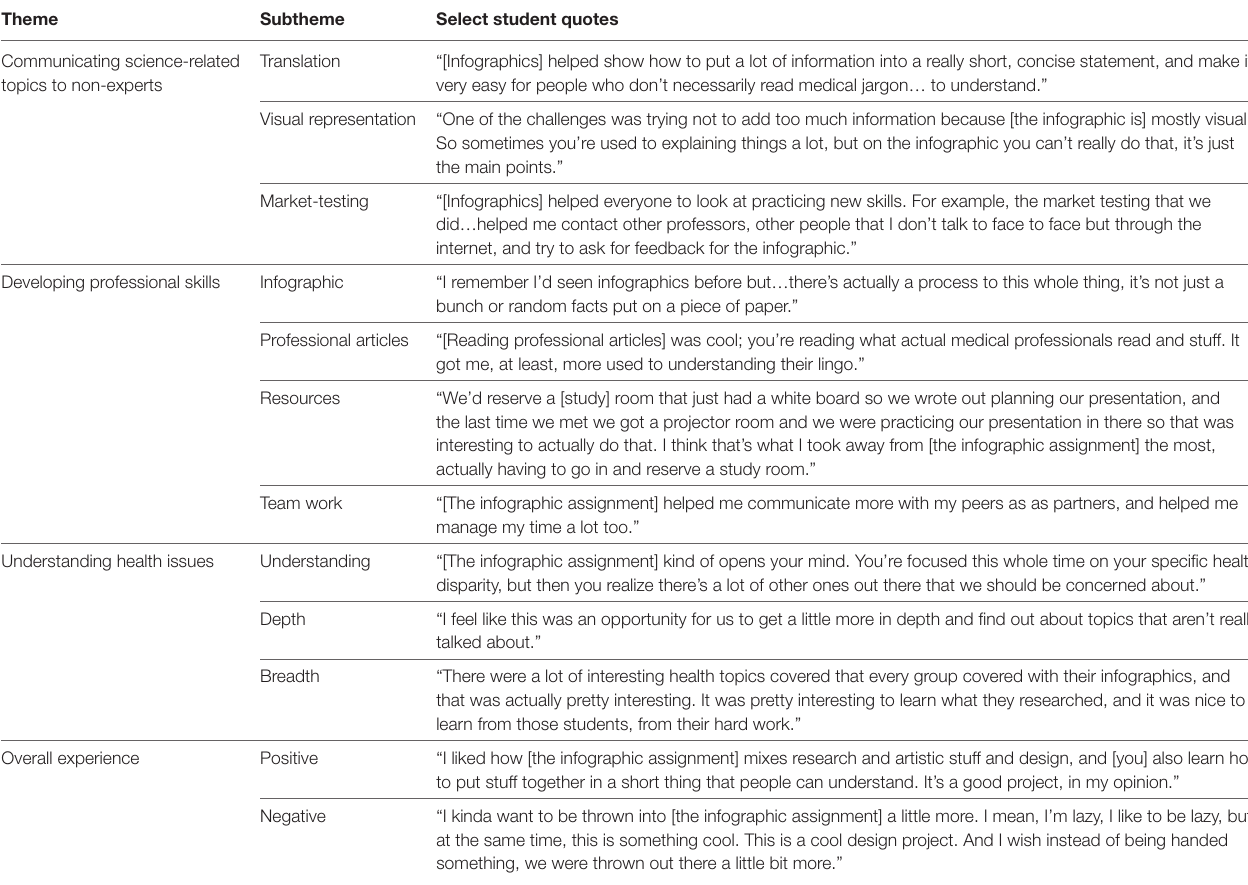
taBle 2 | Student focus group quotes about infographic